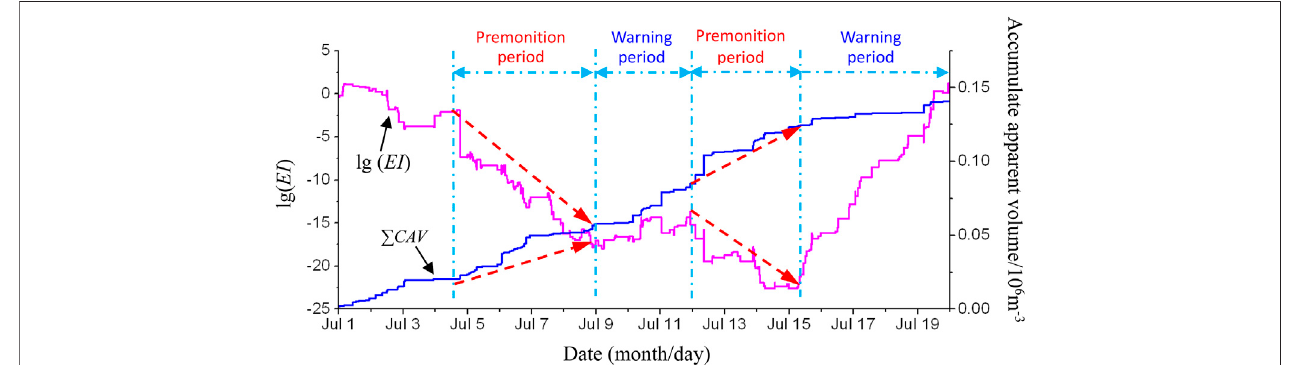
FIGURE 13 | A curve of accumulative apparent volume and energy index with time in diversion tunnel #3.